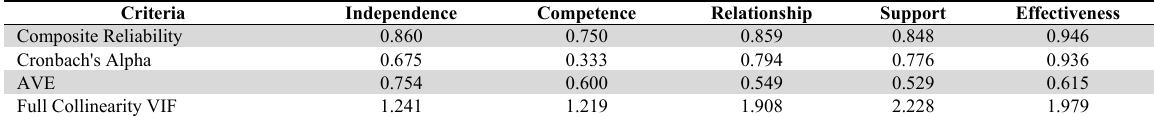
Composite Reliability and Full Collinearity